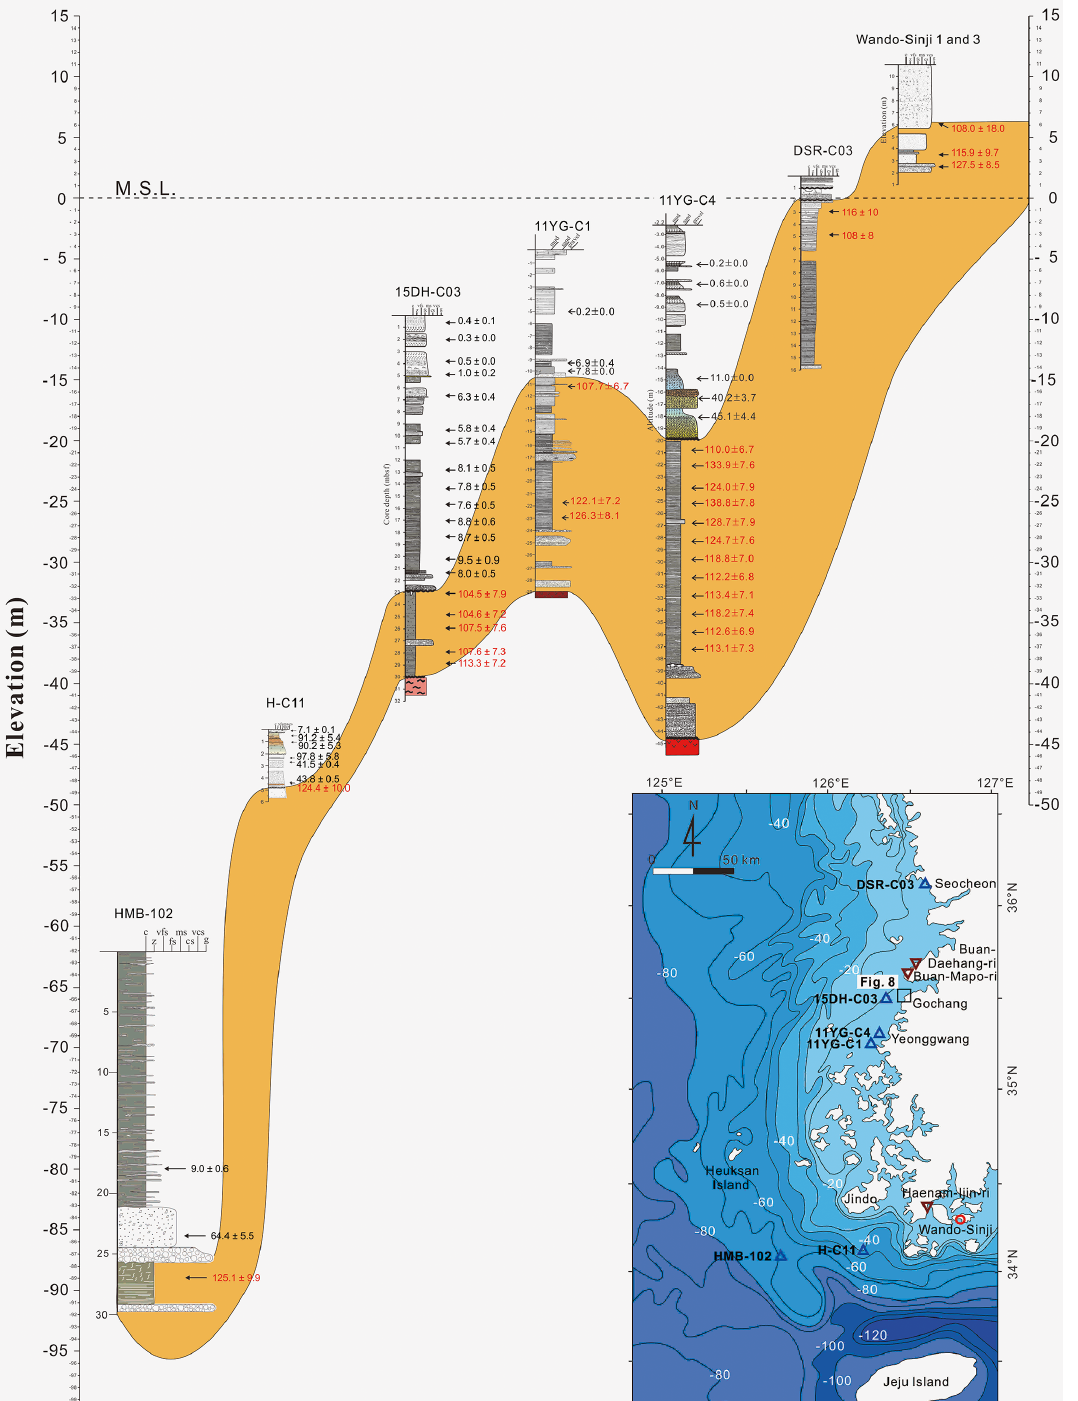
https://doi.org/10.5194/essd-14-117-2022 Earth Syst. Sci. Data, 14, 117–142,